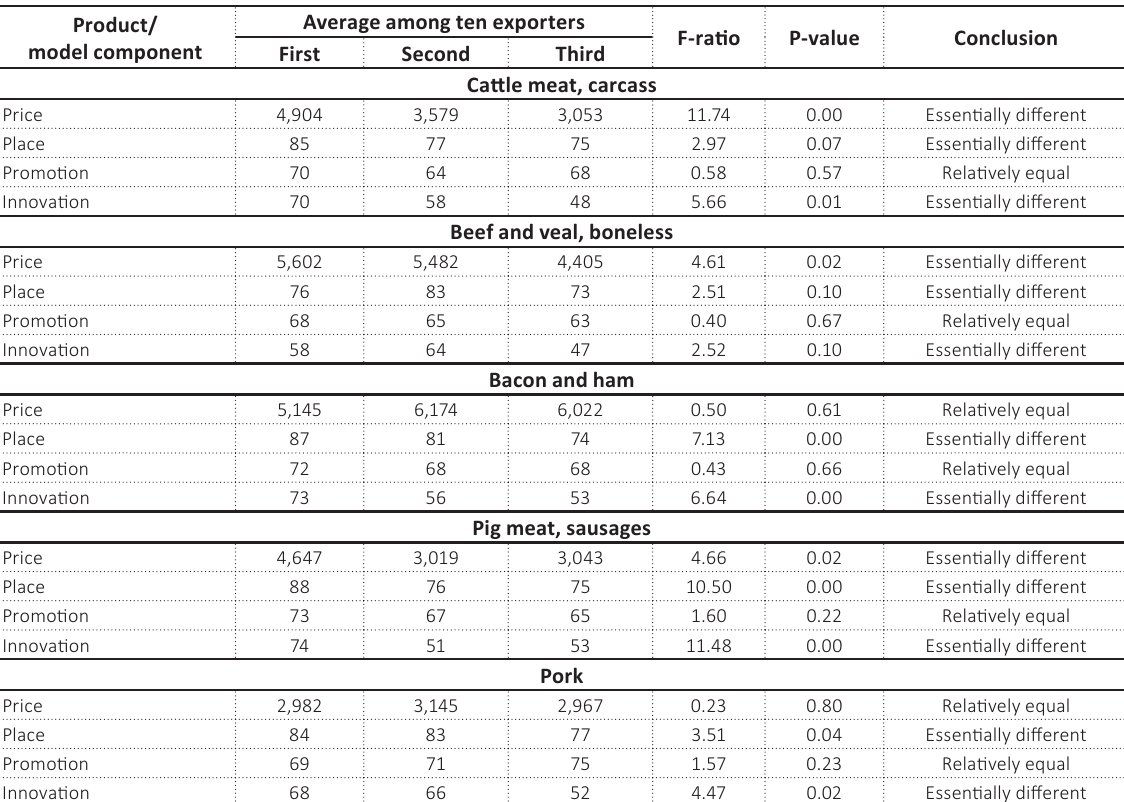
Source: Computed by the